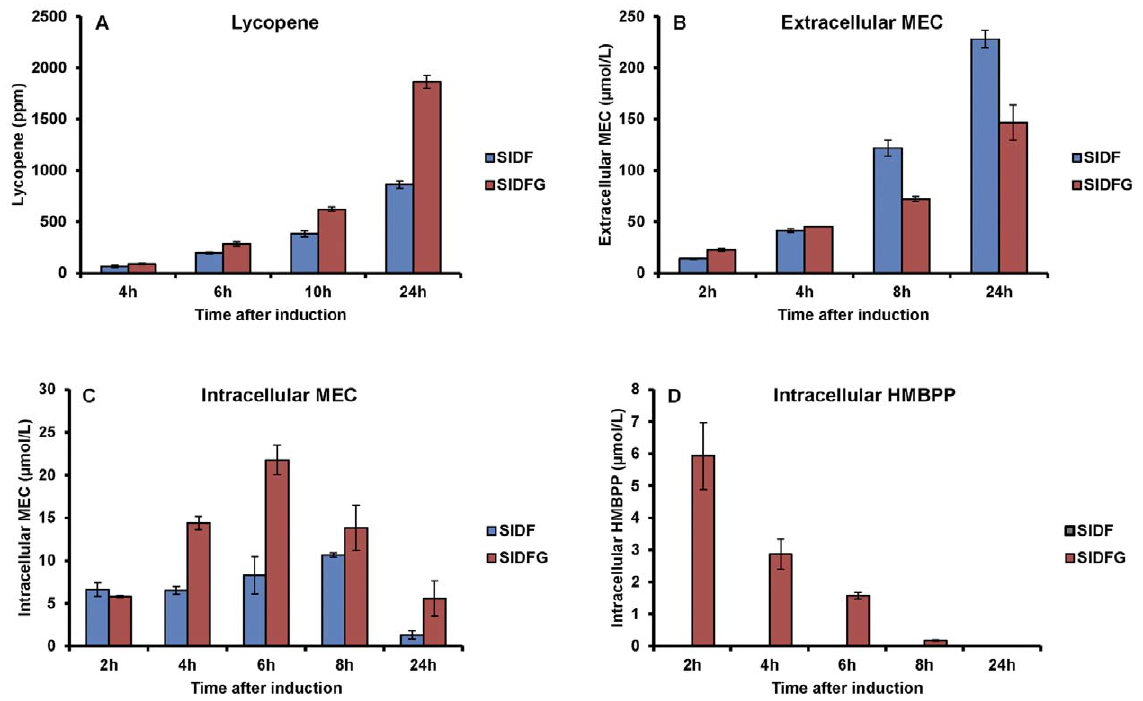
Figure 4. Overexpression of ispG to alleviate efflux of MEC for lycopene production. SIDF: BL21 Gold (DE3) harboring pET-SIDF and pACLYC; SIDFG: BL21 Gold (DE3) harboring pET-SIDFG and pACLYC. (A) Lycopene production as a function of time; (B) Extracellular MEC concentration as a function of time; (C) Intracellular MEC concentration as a function of time; (D) Intracellular HMBPP concentration as a function of time. Presented data were average of triplicates and standard errors were drawn on the plot.